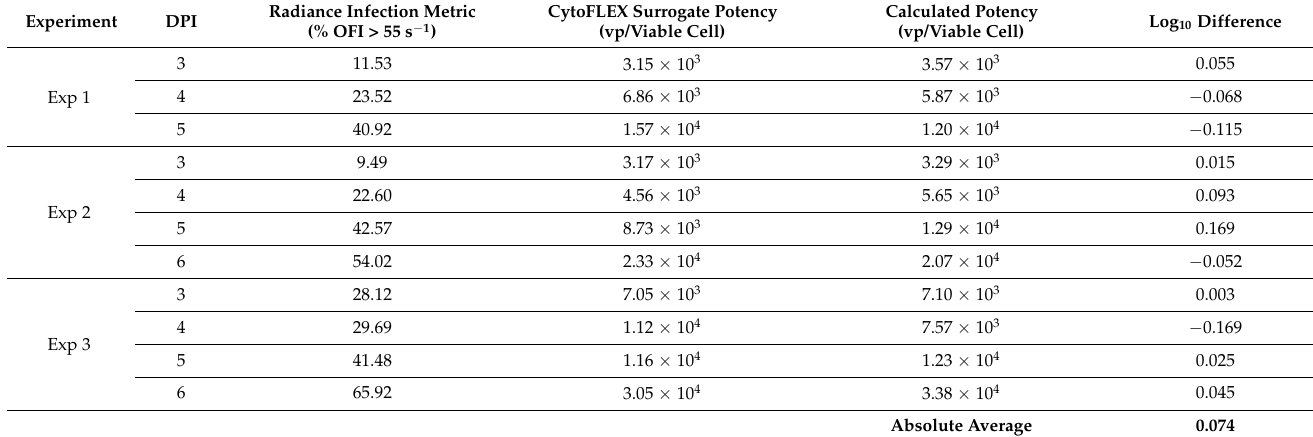
Table 1. Calculated Potency Values for MV-infected bioreactor samples. Table detailing days post- infection (DPI), Radiance infection metric, total virus particle counts used as surrogate potency, and calculated potency in terms of vp/viable cell based on the correlation between the LFC data and flow cytometry data for all three MV 3 L bioreactor experiments. The log 10 difference between the measured and calculated potencies for each sample timepoint as well as the absolute average for all samples across all three experiments are given in the final